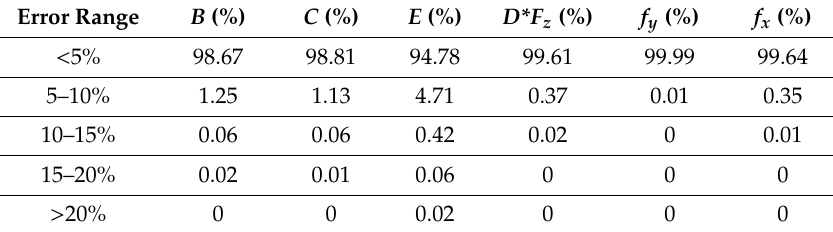
Table 2. Range of values for MF model parameters.